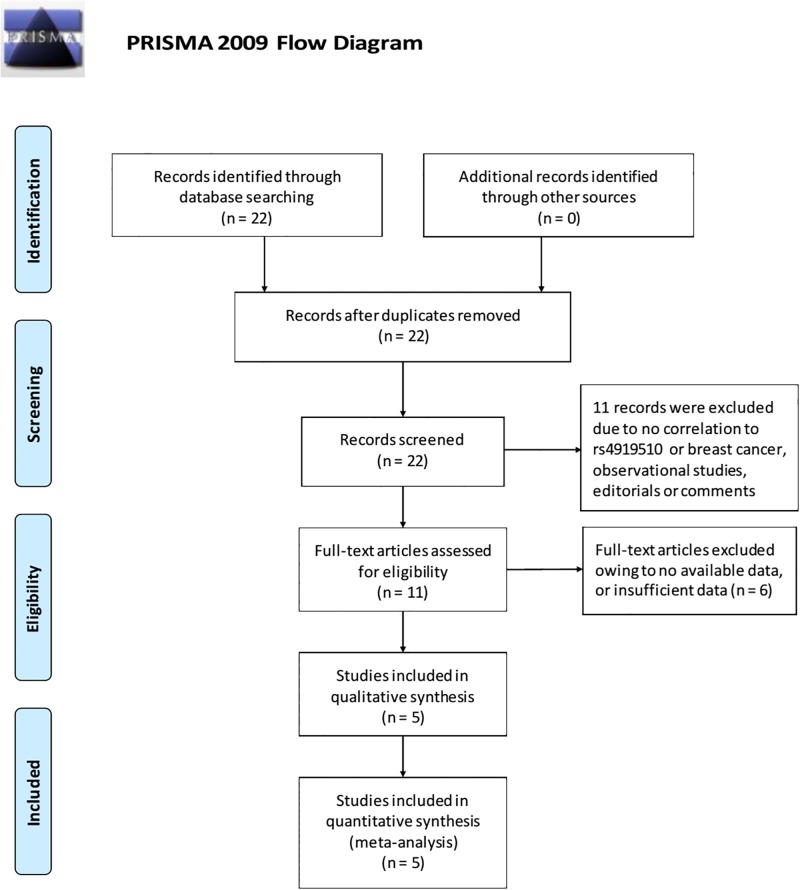
Literature search and selection of articles.From: Moher D, Liberati A, Tetzlaff J, Altman DG, The PRISMA Group (2009). Preferred Reporting Items for Systematic Review s and Meta-Analyses: The PRISMA Statement. PLOS Med 6(6):e1000097. Doi:10.1371/journal.pmed1000097. For more information, visit
www.prisma-statement.org.